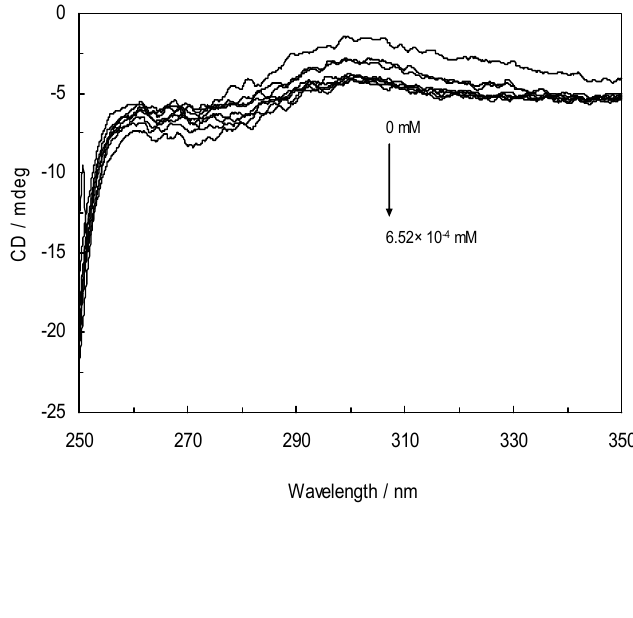
Figure 9. Near-UV CD spectra of HSA-NRF in the absence and presence of